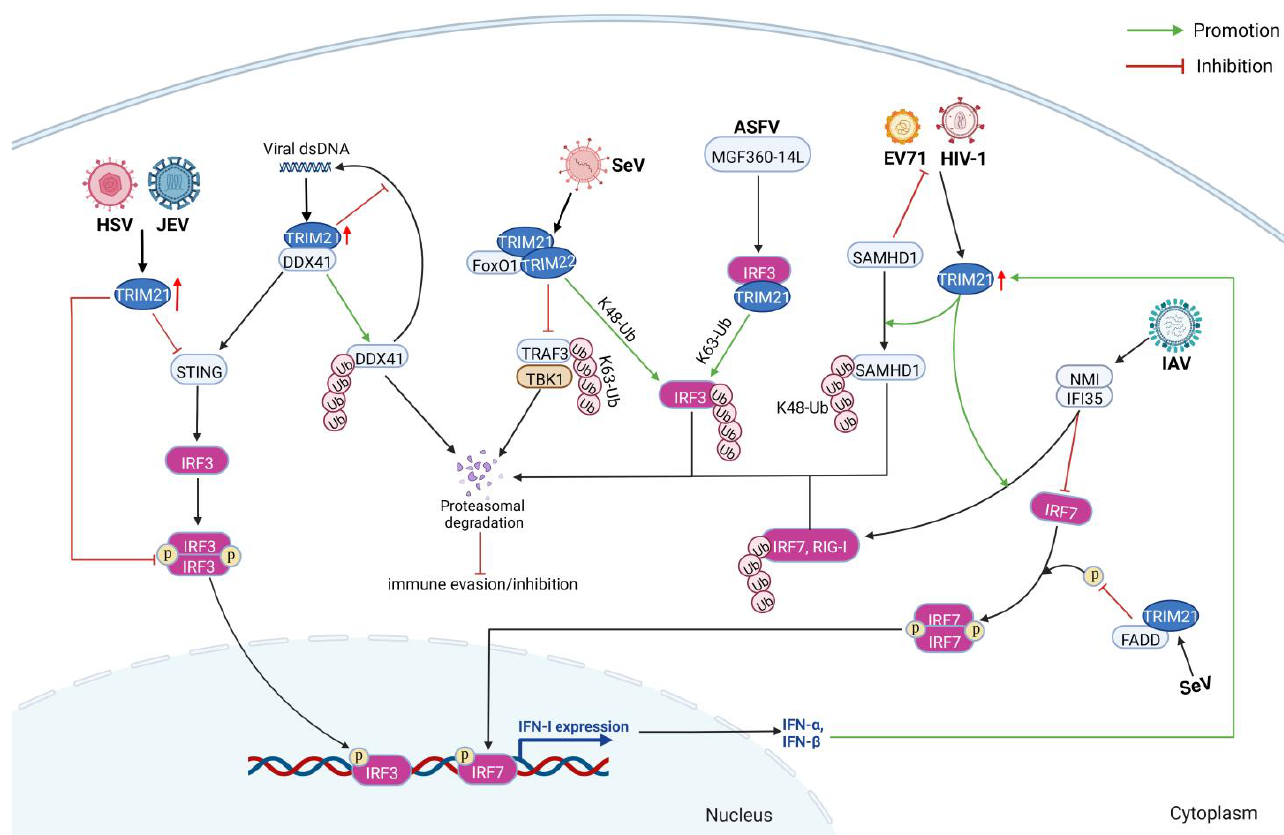
Figure 6. TRIM21 is a negative regulator of immune responses during virus infection. The ubiquiti- nation of IRF3/7 or its upstream sensors by TRIM21, such as STING, DDX41, NMI/IFI35, and RIG-I, leads to immune suppression during virus infection. Finally, the replications of viruses, including SeV, IAV, HSV-1, ASFV, and JEV, were enhanced in TRIM21-dependent manners. Figure created with BioRender.com.